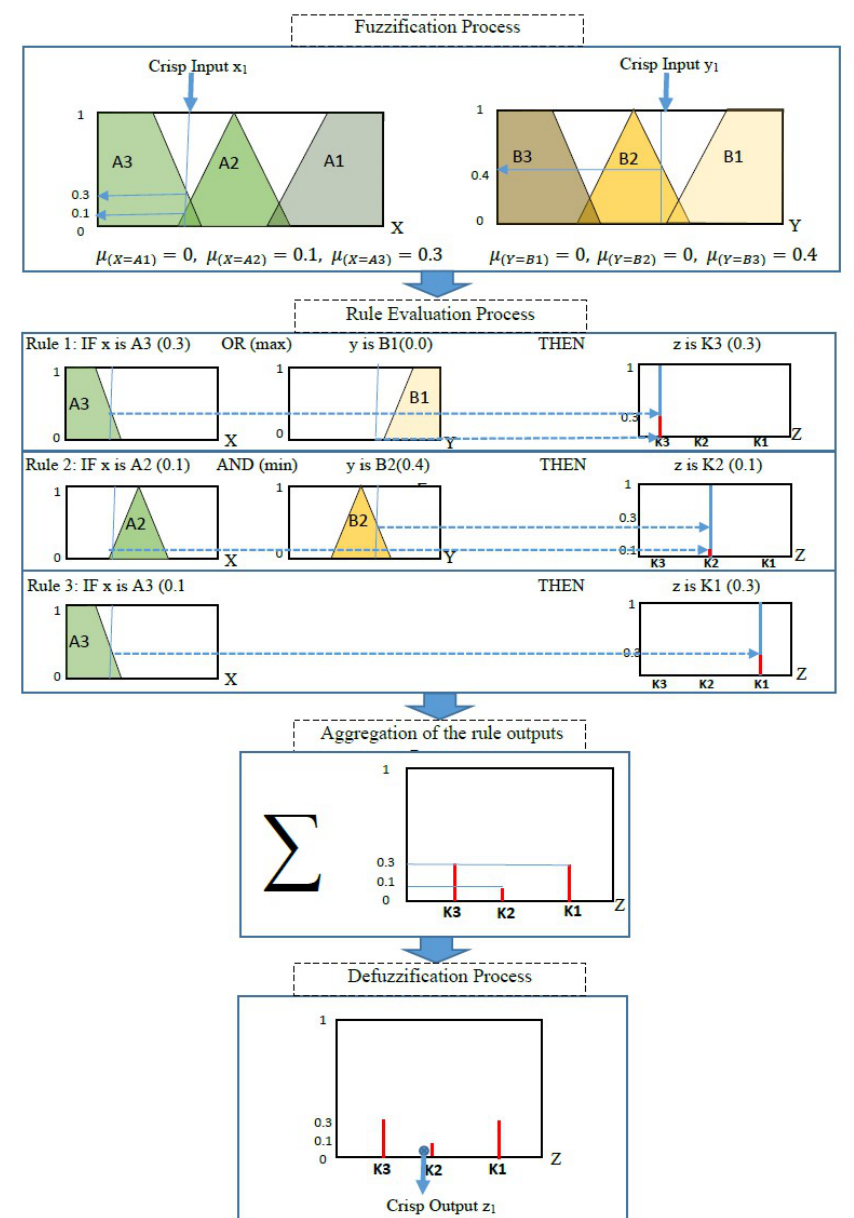
Figure 1. The structure of Sugeno fuzzy